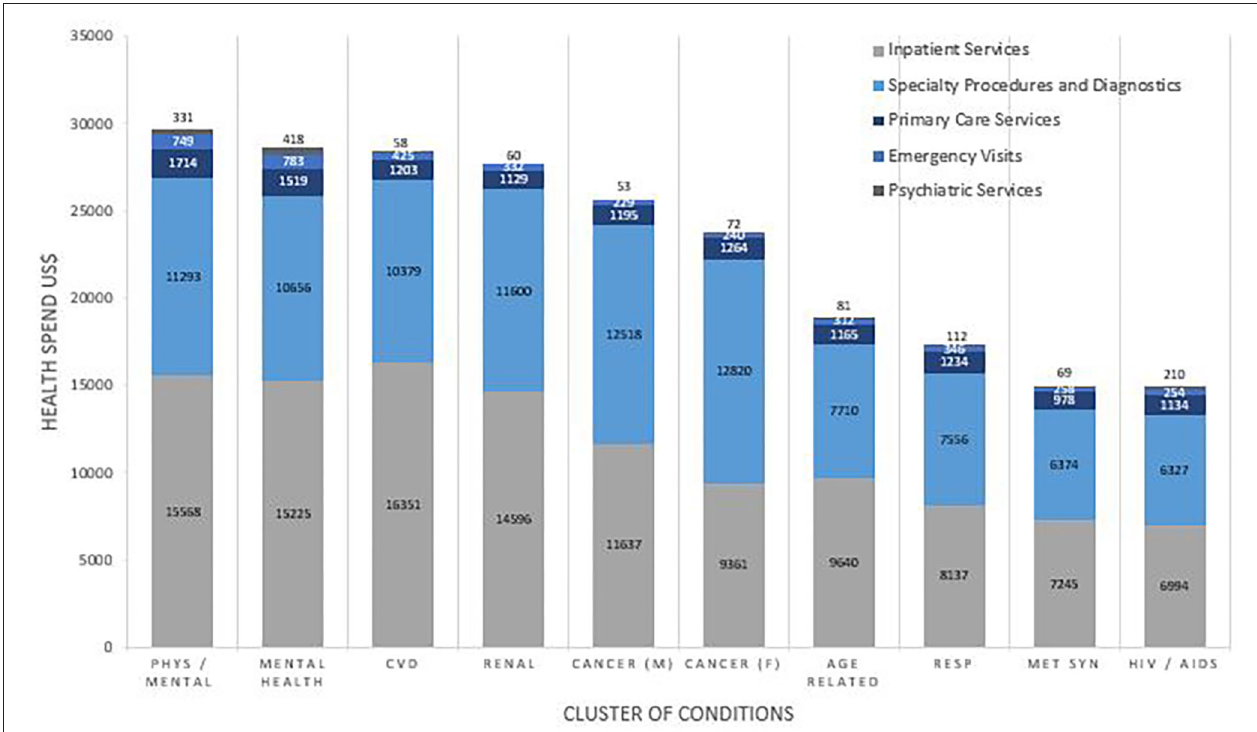
FIGURE 3 | Health Service Utilization in terms of cost, reported by Cluster. Costs are weighted to the US population and are reported in US$. Comparisons for cost between clusters of conditions were statistically significant for inpatient ( p < 0.001), specialty procedure ( p < 0.001), primary care ( p < 0.001), emergency care ( p = 0.003), and psychiatric care ( p <